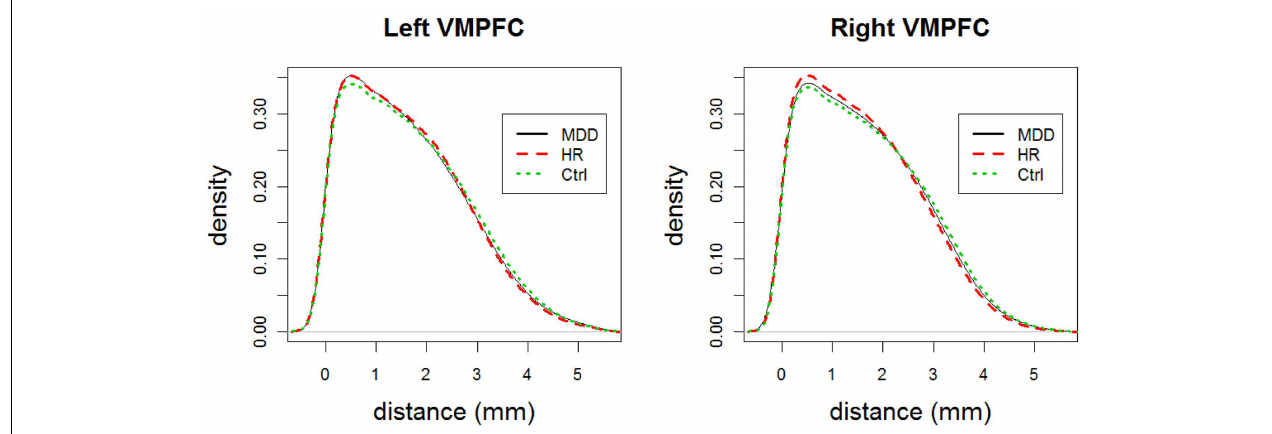
FIGURE 6 |The plots for the kernel density estimates of the pooled LCDM distances for each of MDD, HR, and Ctrl groups for left and rightVMPFCs .